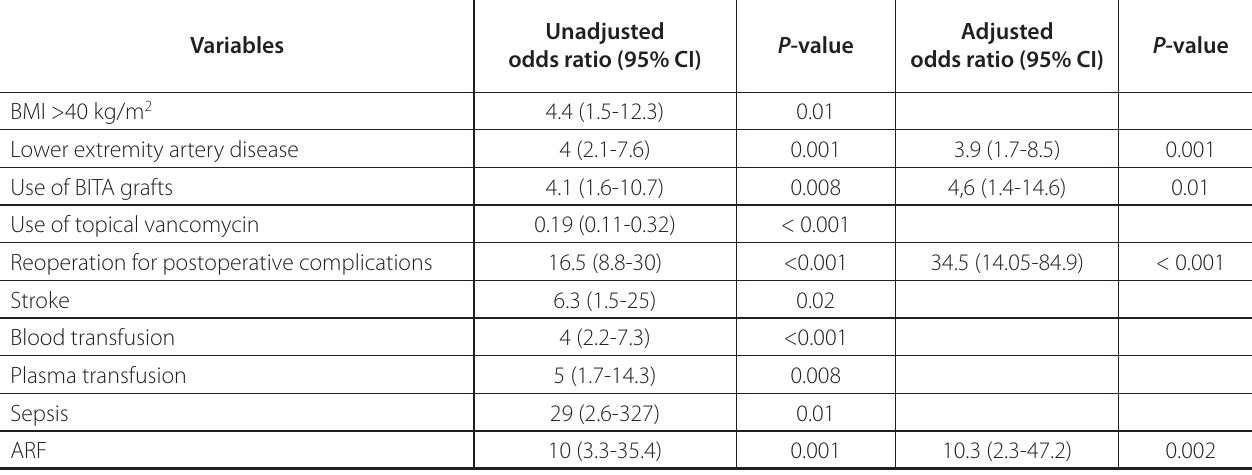
Table 4 . Univariate and multivariate logistic regression analysis showing parameters associated with DSWI after OPCAB.